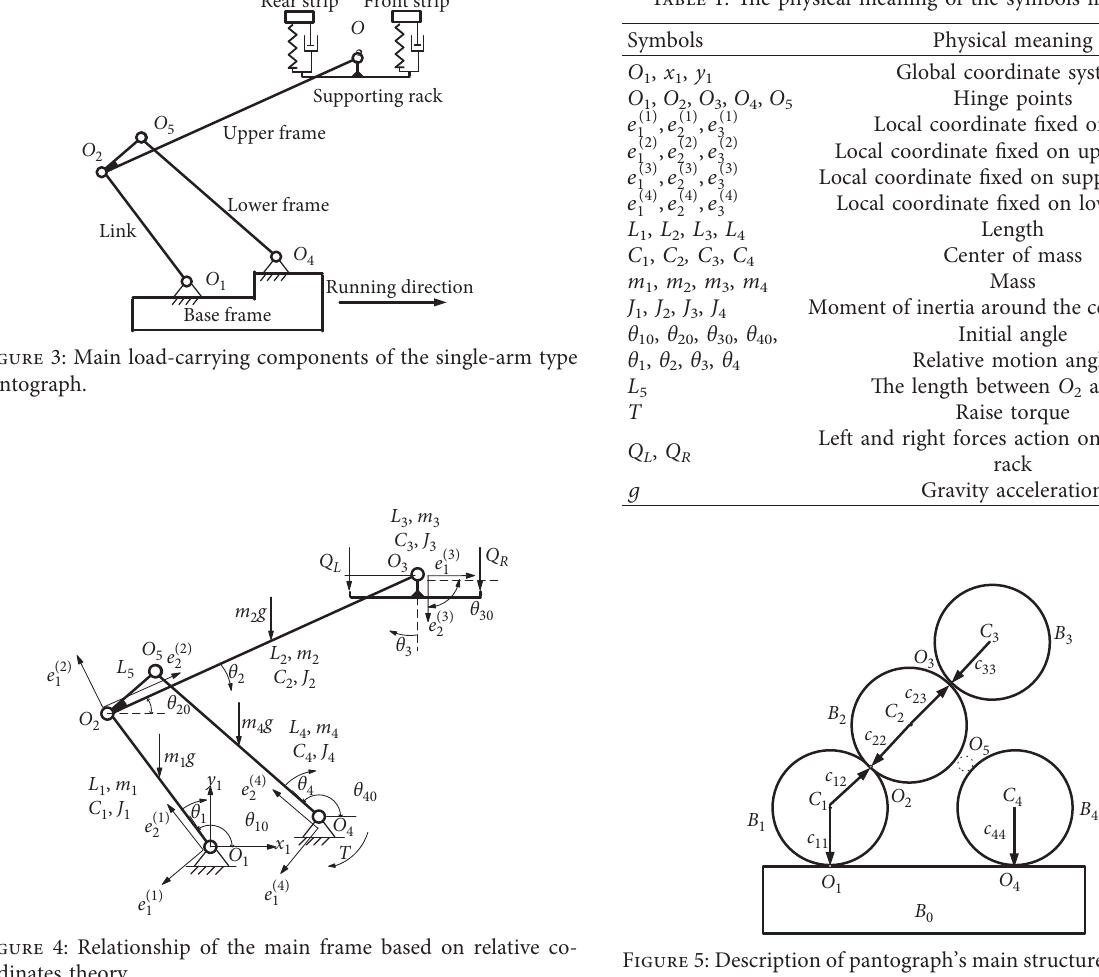
Table 1: The physical meaning of the symbols in Figure 4.